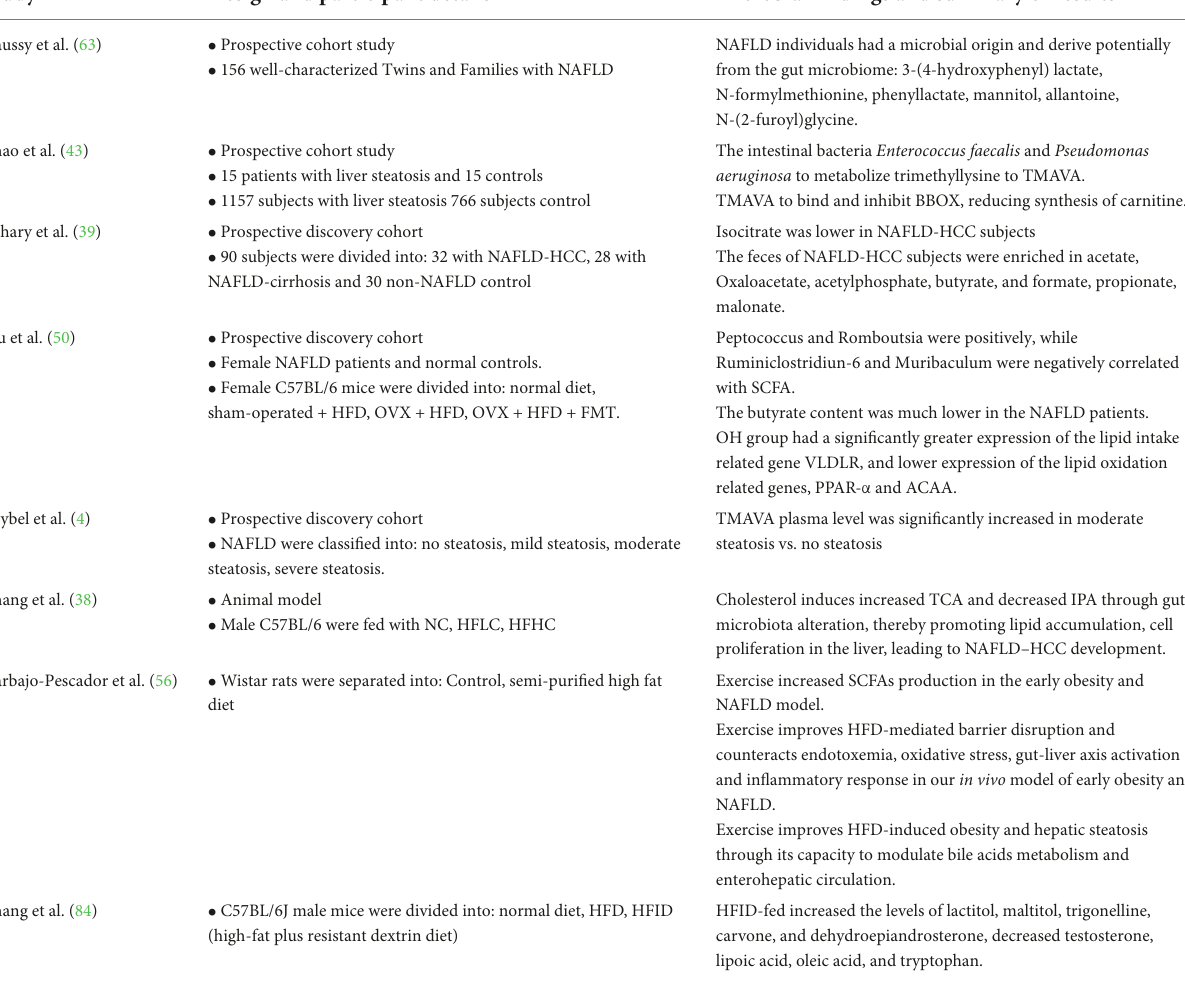
TABLE 2 Investigations into NAFLD and microbiota